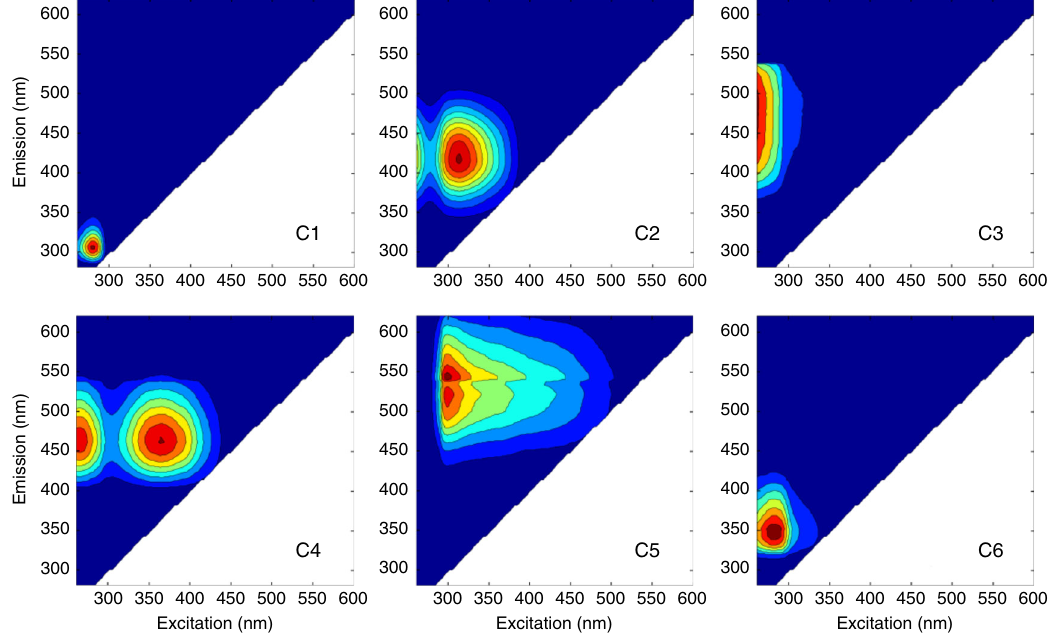
Fig. 3 Six fl uorescent components identi fi ed using PARAFAC analysis. Excitation and emission peak positions of the three-dimensional excitation- emission matrices of the independent components are indicated alongside descriptions in Table 1.